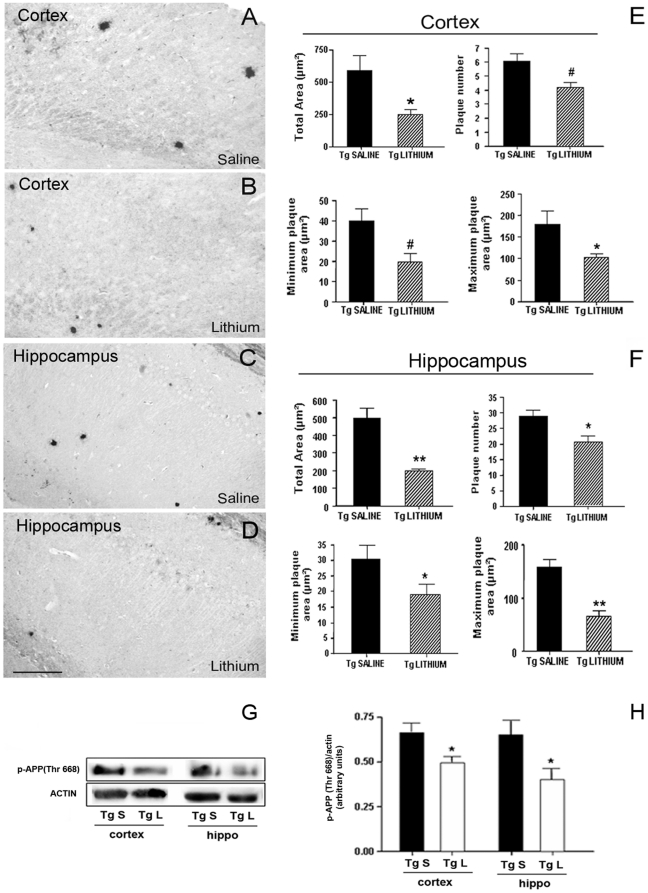
Lithium reduced Aβ burden and phospho-APP(Thr668) levels in 3-month-old TgCRND8 mouse brain.A–D representative photomicrographs of Aβ (1–42) immunolabelled amyloid plaques in the cortex (A,B) and hippocampus (C,D) of saline-treated (A,C) and lithium-treated (B,D) Tg mice. E,F: Quantitative analyses of the total area, plaque number and minimum and maximum plaque area in the cortex and hippocampus of saline-and lithium-treated Tg mice. Note in B and D and in the bar graphs the significant reduction of amyloid load by lithium treatment (Student's t-test, *P<0.05, #P = 0.02, **P<0.01 versus Tg saline). Scale bar = 100 µm applies to all images. (G) qualitative Western blotting analysis of p-APP(Thr668) levels. β-actin was used as a protein loading control. (H) Quantitative analysis of protein levels showing a statistically significant decrease of p-APP(Thr668) levels in the cortex and hippocampus of lithium-treated Tg mice compared with saline-treated Tg controls. (One-way ANOVA plus Bonferroni's post hoc test,*P<0.05 versus Tg saline).